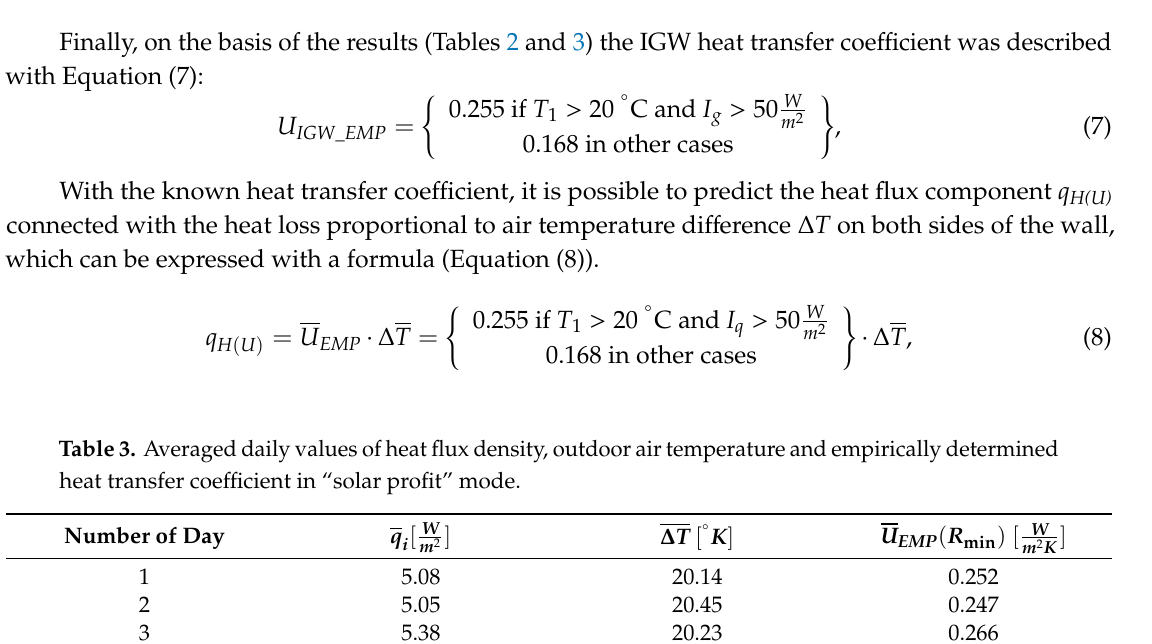
Table 2. Averaged daily values of heat flux density, outdoor temperature and empirically determined heat transfer coefficient.